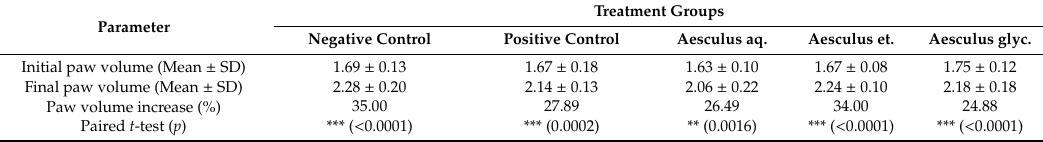
Table 3. Hind paw volume (cm 3 ) of rats receiving intraplantar kaolin and topical gels. Treatment Groups Parameter Negative Positive Aesculus aq. control control